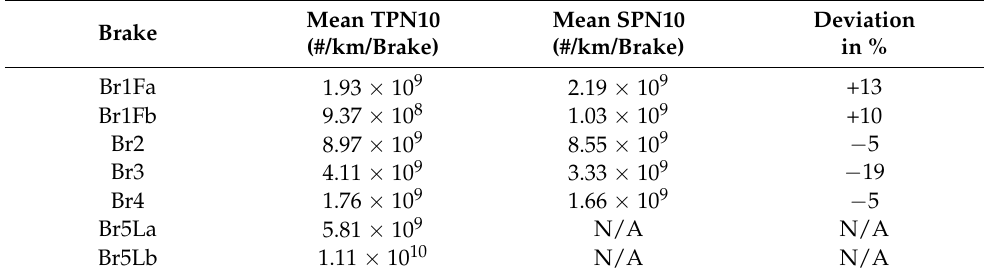
Table 4. Mean TPN and SPN emission factor, excluding Lab T measurements for Br1Fa.